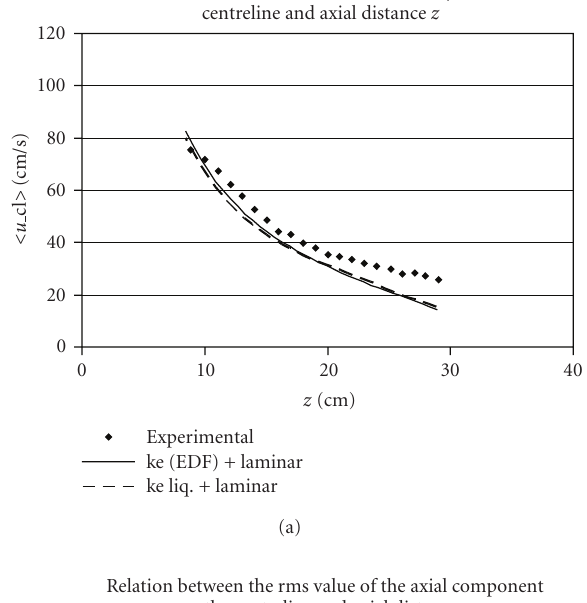
Figure 1: Iguchi’s experiment: fluid domain.